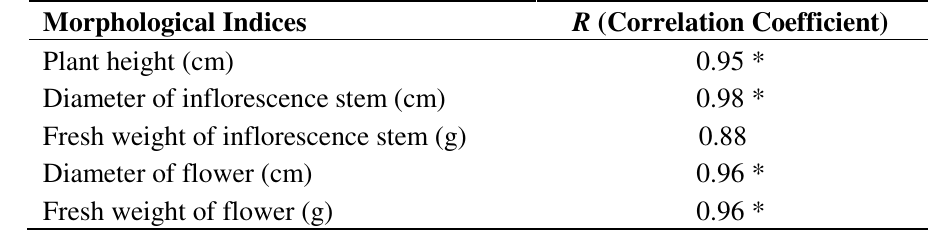
Table 2. Correlation of morphological indices and mechanical strength of inflorescence stem.